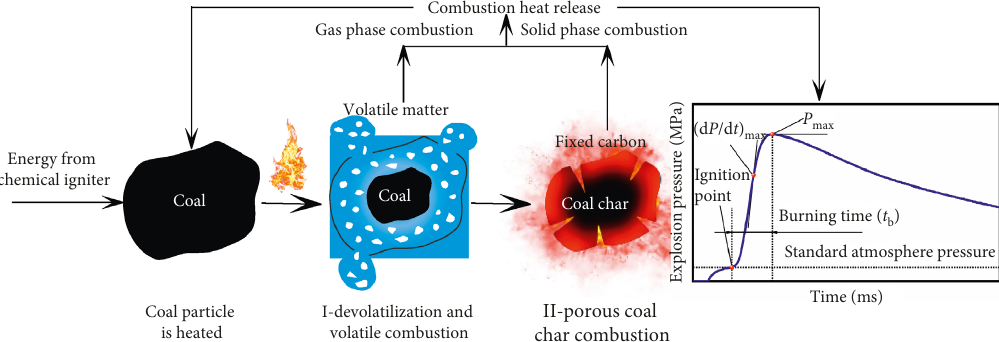
Figure 9: Explosion mechanism of the coal